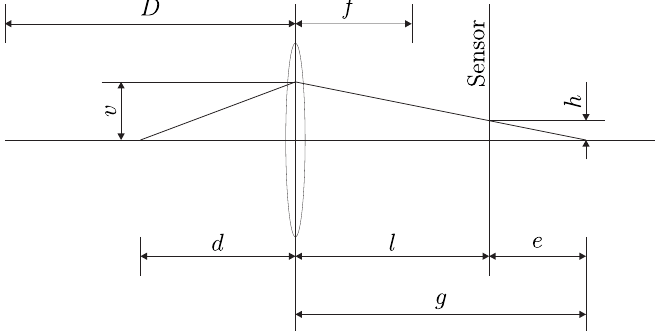
Figure 4. Geometry of a single aperture of an out-of-focus image (adapted from [24]). Here, the following abbreviations are used: D is the distance of an object to the lens plane, f the focal length, v the displacement of the aperture, d the distance of the object to the lens plane, l the distance between the lens plane and the sensor plane, e the distance of the conjugate focal point beyond the sensor, g the distance to the conjugate focus of the object and h the displacement of the object’s image in the sensor